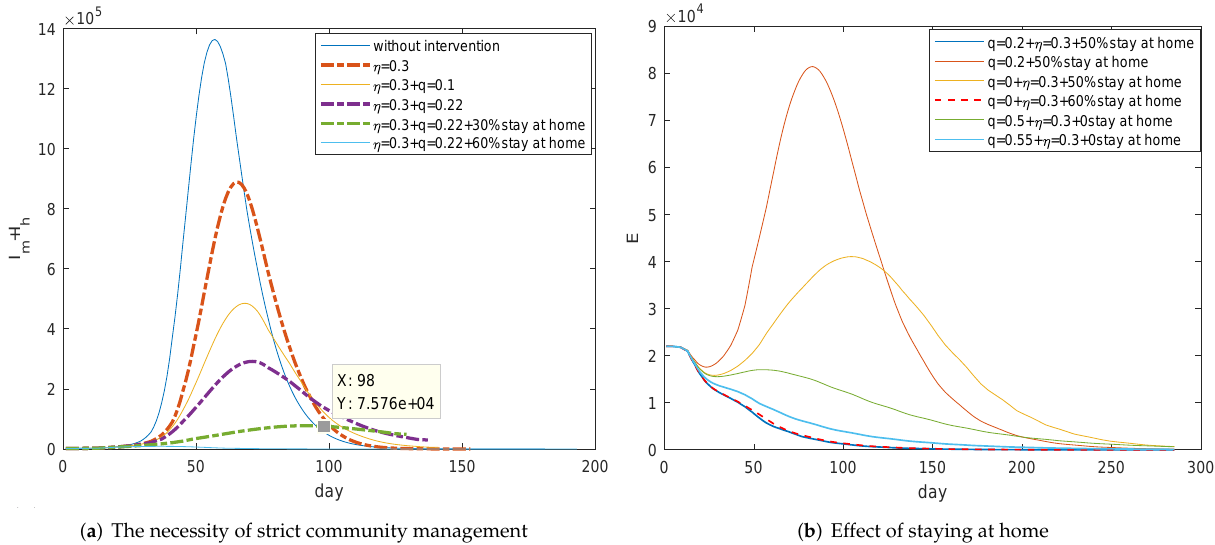
Figure 7: Investigations on the effect of staying at home management in Wuhan (a) It needs at least 30 percent removal rate and 22 percent tracking rate with improved awareness to contain the spread. (b) 50 percent removal rate and 22 percent tracking rate with improved awareness can eradicate the epidemic soon. COVID-19 also can be controlled with awareness protection and at least 50 percent tracking rate.